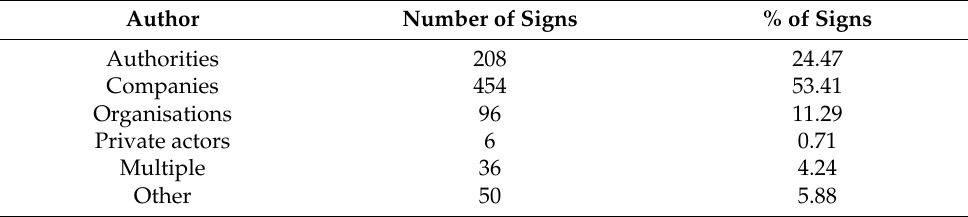
Table 1. Authors of signs (N = 850).